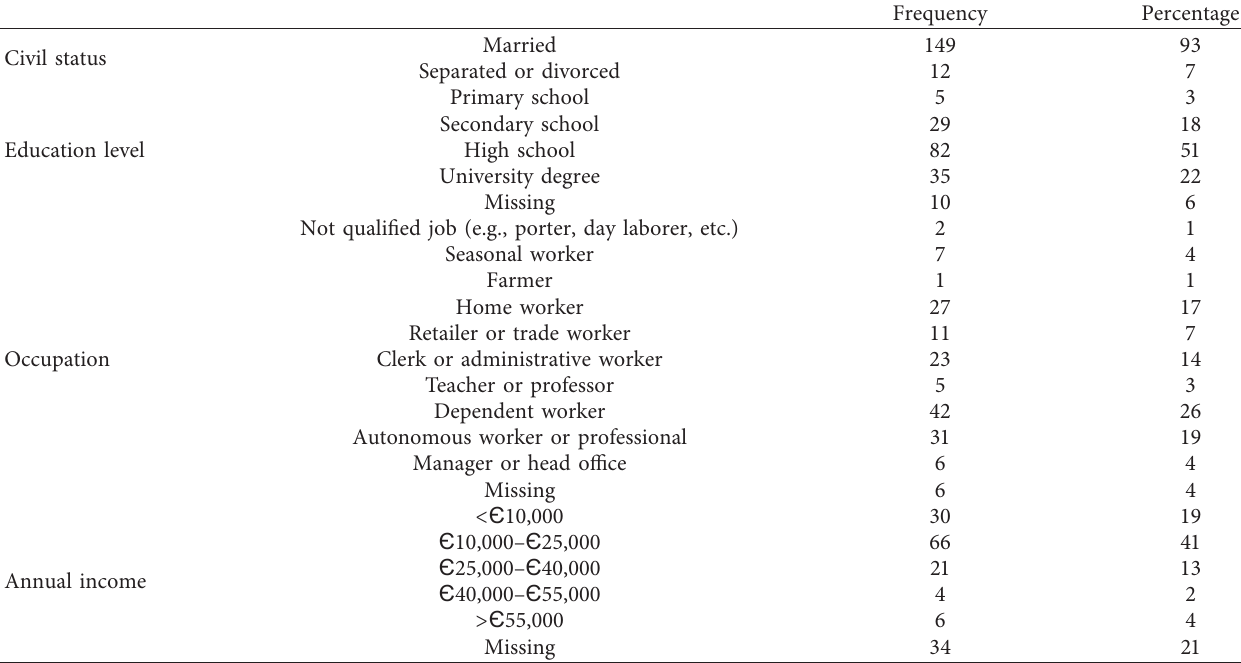
Table 1: Demographic characteristics of parents ( n � 161) who participated in the